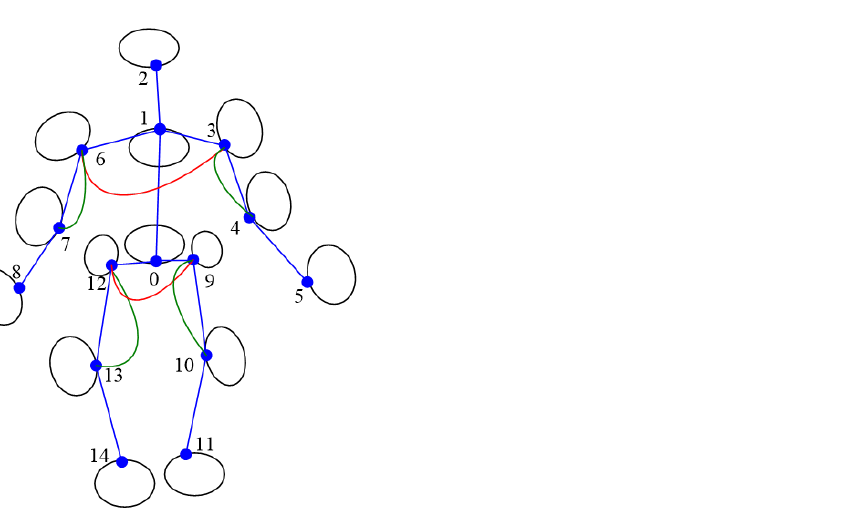
Figure 12. Graph model in our algorithm. Black edges denote the projection constraints, blue ones denote the bone length constraints, red ones denote the 3D orientation constraints and green ones denote the reverse joint constraints. The inverse joint correction algorithm is not shown in the figure because it is not an optimization algorithm.